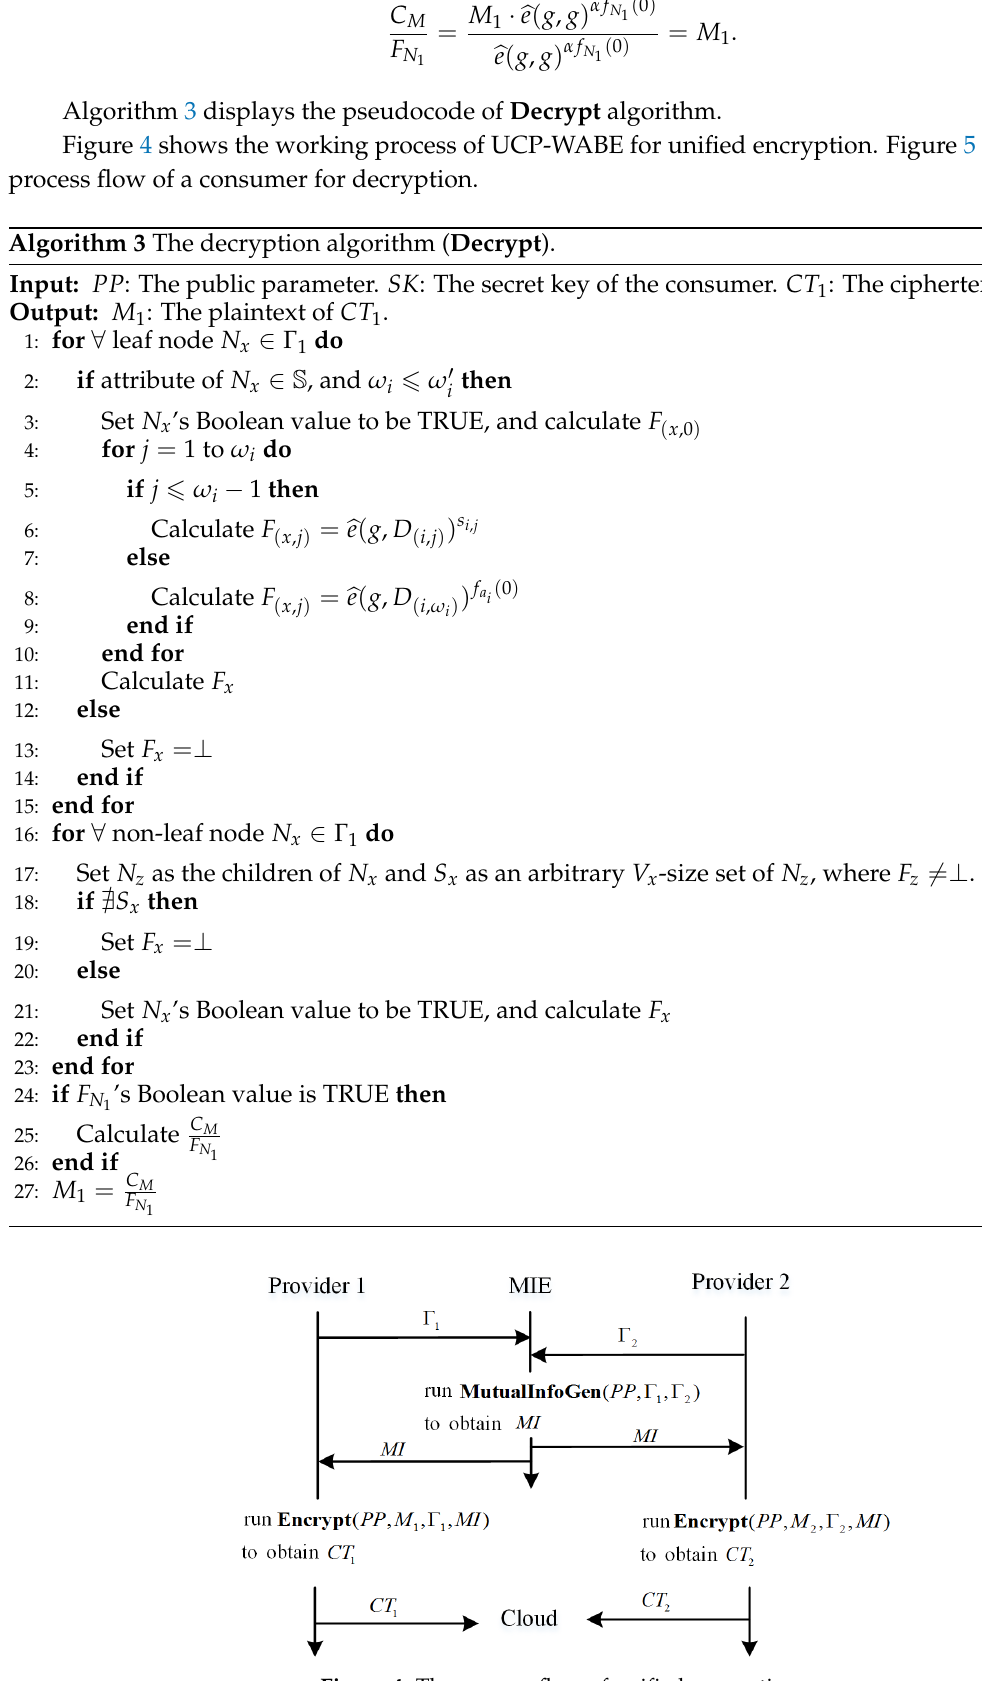
Figure 4. The process flow of unified